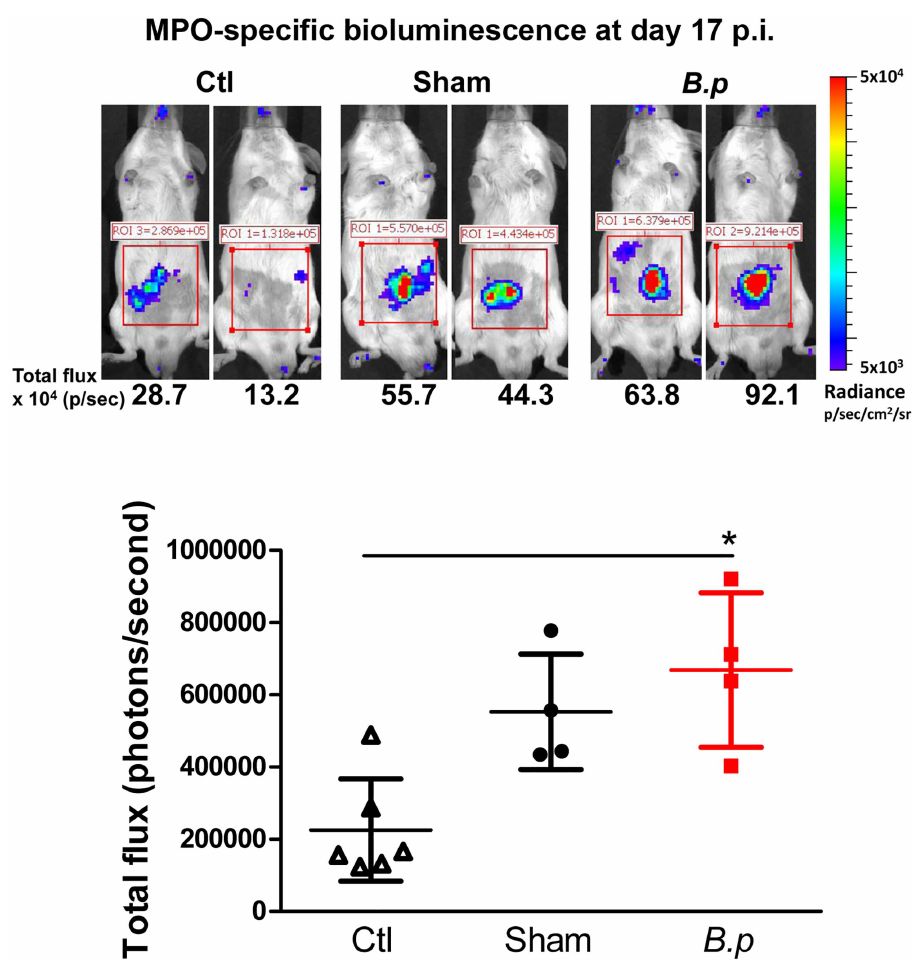
Fig 1. In vivo imaging of MPO-specific bioluminescence in mice implanted with adult B . pahangi . BALB/c mice were infected intraperitoneally by transplantation with 10 female adult B . pahangi(B . p) . Sham- operatedmice (Sham) receivedno worms and control mice (Ctl) received an intraperitoneal injectionof HBSS but underwent no surgery. On day 17 post-infection mice were imagedusing an IVIS spectrum 20 minutes after subcutaneous injectionof 200 mg/kg luminol. Representative images of 2 mice per group are shown. The colour scale indicatesbioluminescence radiancein photons/second/cm 2 /steradian. Graphs show the bioluminescence total flux (in photons/second) within the same abdominalregionof interest. Each symbol shows the total flux for a single mouse, lines indicatethe means (n = 4–6 mice) and error bars show SD ( * p < 0.05 using a one-wayANOVA with Dunn’spost-test).